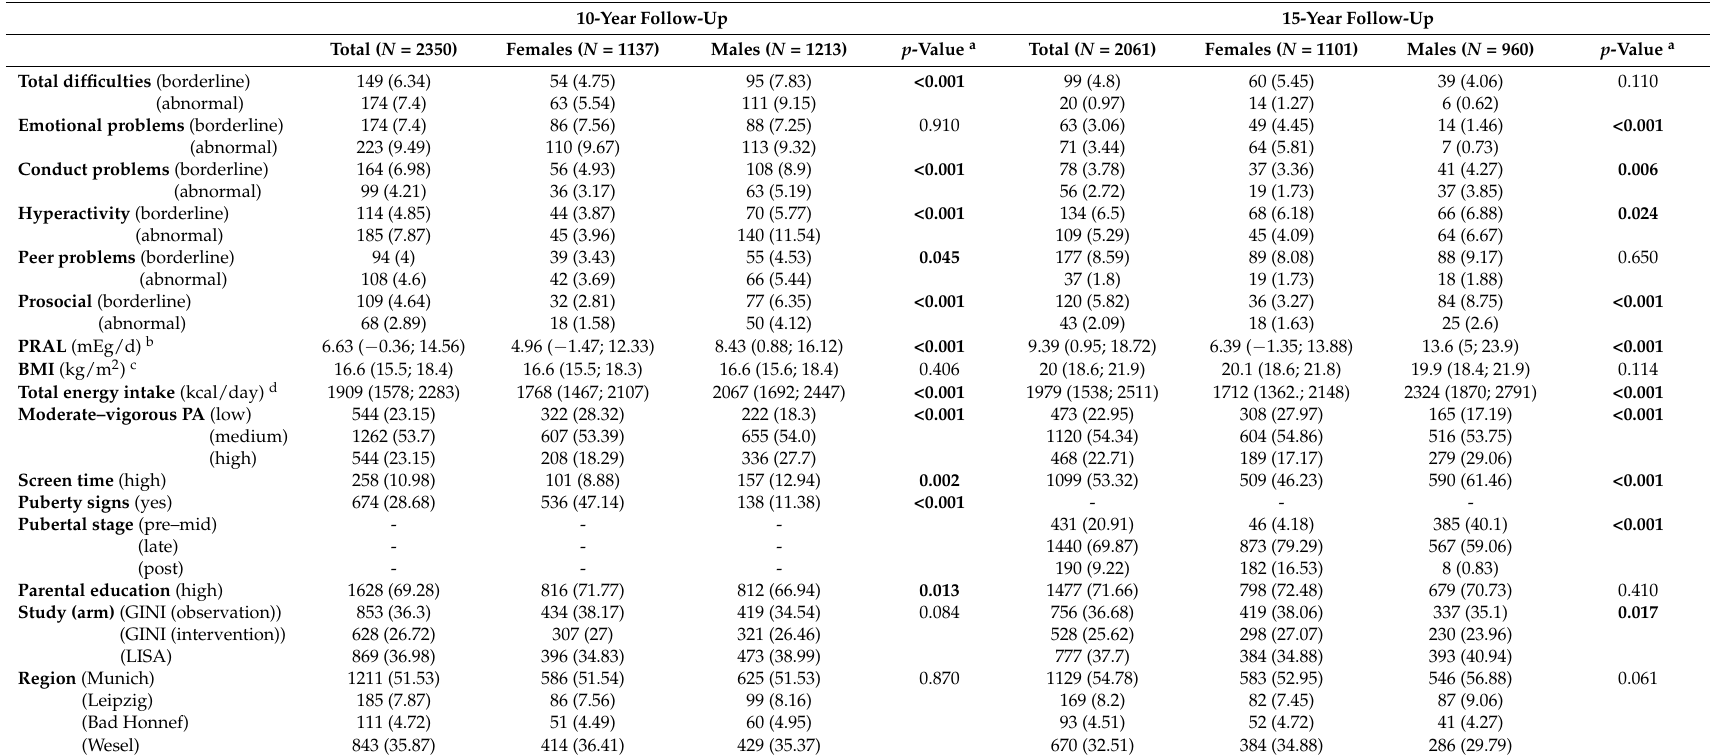
Table 1. Descriptive characteristics of study population at the 10-year and 15-year